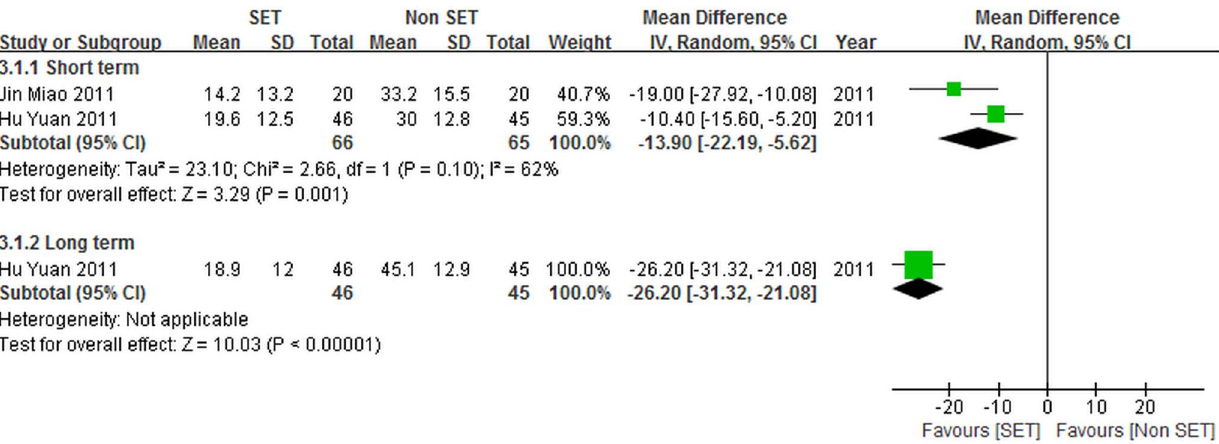
Figure 5. Self-reported pain for sling exercise versus thermomagnetic therapies.